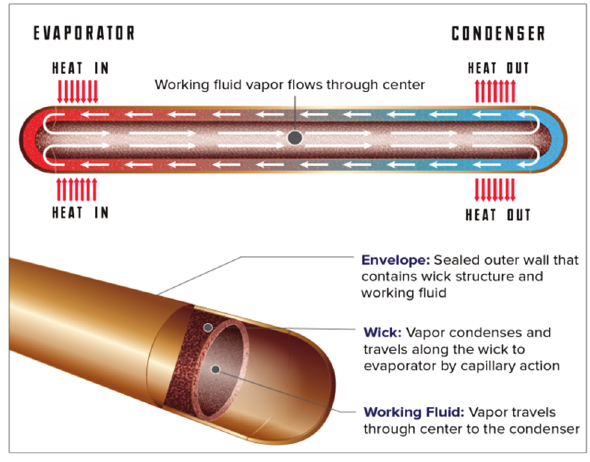
Fig. 1. Illustration of heat pipe operation [21] Temperature range in which the heat pipes operate properly as well as their lifetime depend on a type of work- ing fluid used and the envelope. In Table 1 sample fluids and the respective operational temperature ranges are given. Use of heat pipes in place of homogeneous heat con- ductors (rods), allows to limit the dimensions and mass of heat exchangers. For instance, a heat pipe of a diameter 6 mm, length 30 cm, at temperature difference of 3°C can transfer 180 W of heat. To achieve the same effects using a homogeneous copper pipe of the same length, its diame- ter would have to be 24.4 cm and the weight would be around 125 kg